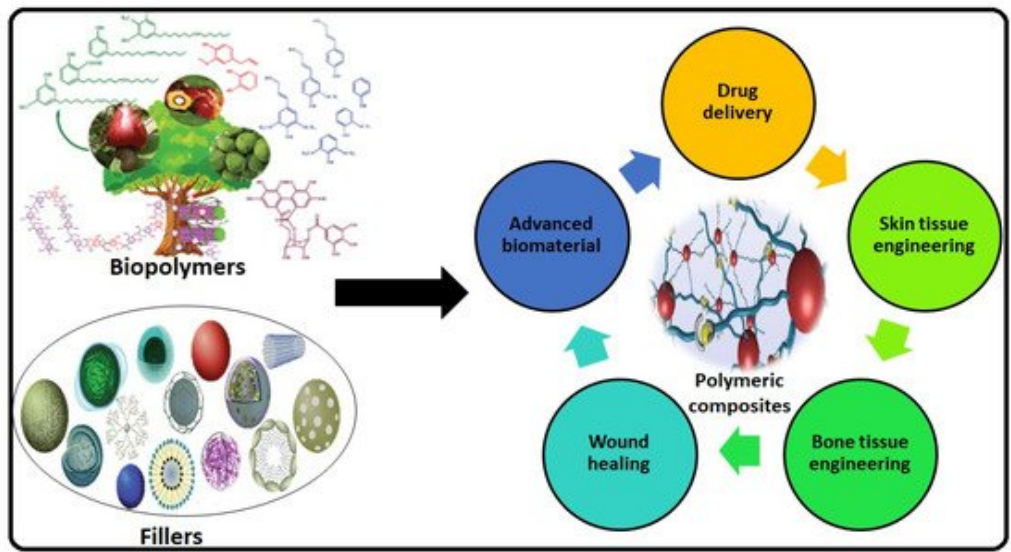
Figure 13. A graphical description highlighting the numerous promising functionalities of biodegradable polymerics with numerous filler particles. Reproduced with permission from [313].